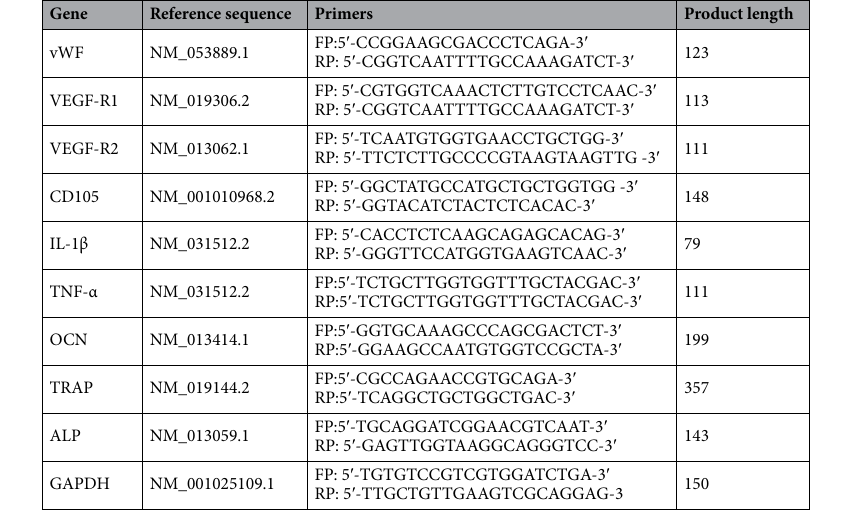
Table 1. Primer sequences, utilized for gene expression